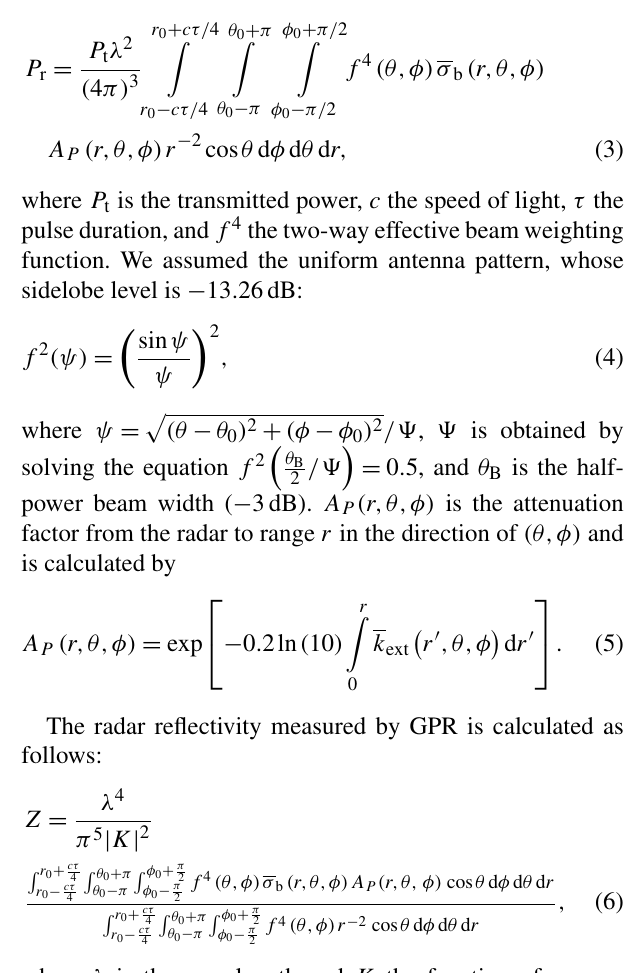
Table 1. Specifications of the precipitation radar aboard geostation- ary satellite.